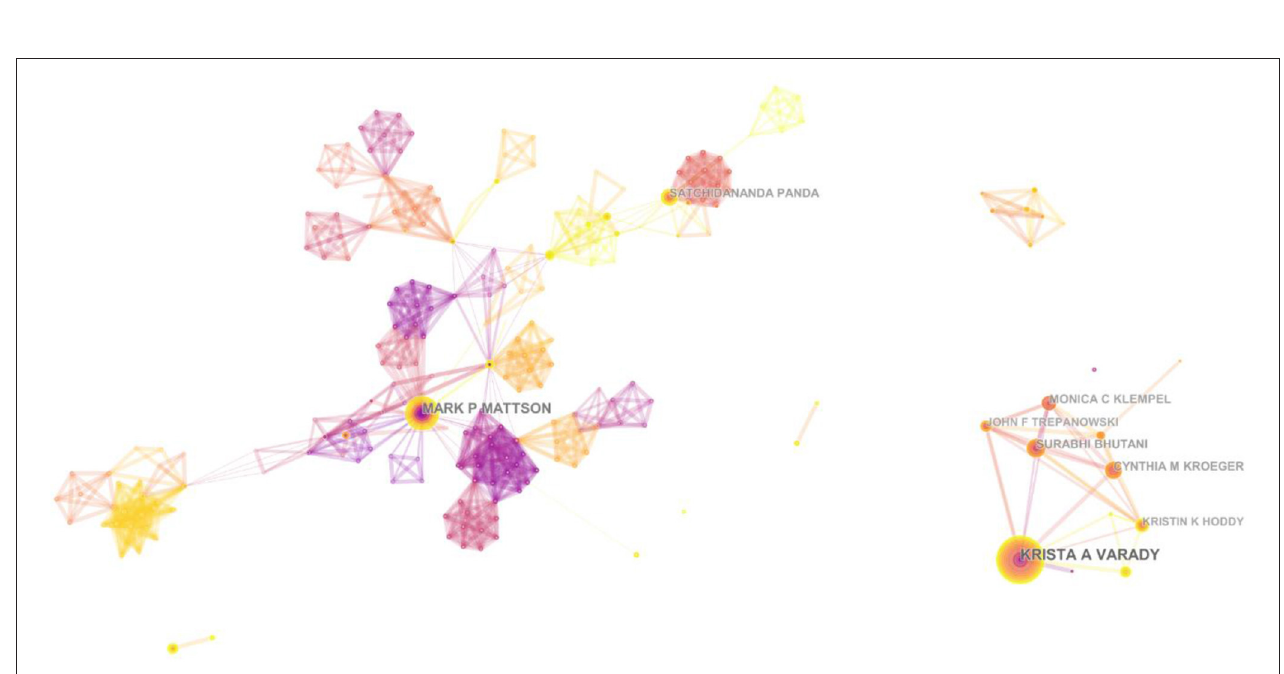
FIGURE 6 | Knowledge map of co-author collaboration network.